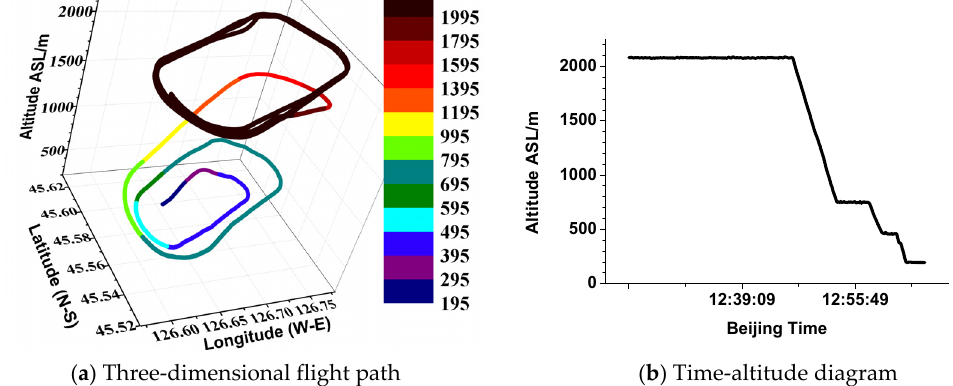
Figure 3. The flight path during the descent phase on 20 October 2016. ( a ) Three-dimensional flight path; ( b ) Time ‐ altitude diagram.